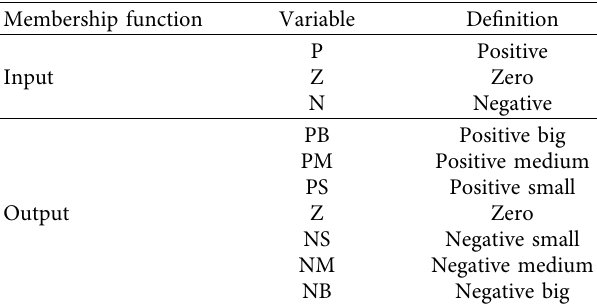
Figure 3: Output membership functions (force). Table 6: The concept of input and output.